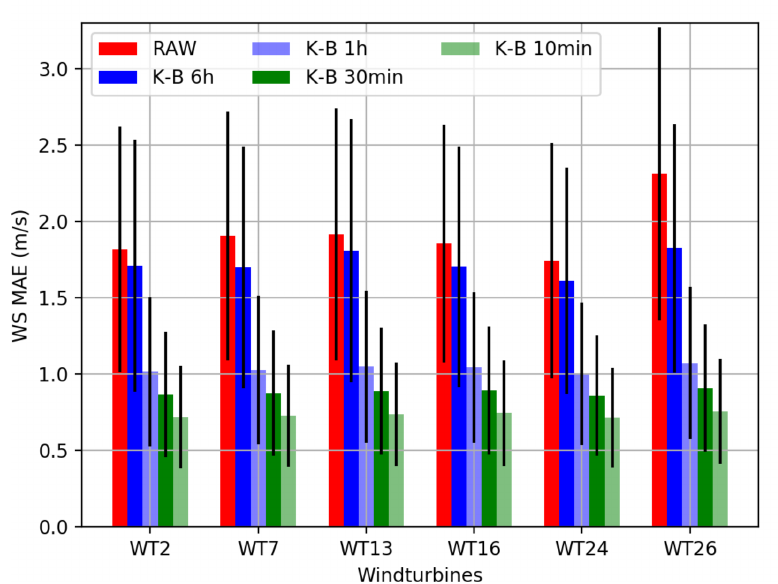
Figure 2. Barchart with annual WS MAE for all experiments and wind turbines analyzed. For each case, the standard deviation ( σ ) is represented by a black line on top of each